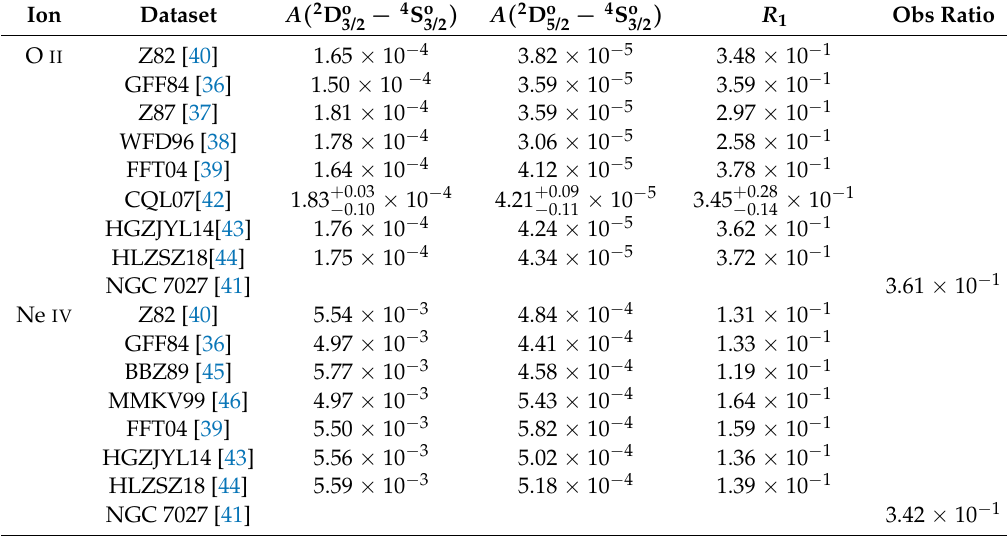
Table 1. Theoretical A -values (s − 1 ) for the 2 D o configuration of N-like O II and Ne IV . The R 1 ratio is also given for comparison with the line intensity ratio observed in the dense NGC 7027 planetary